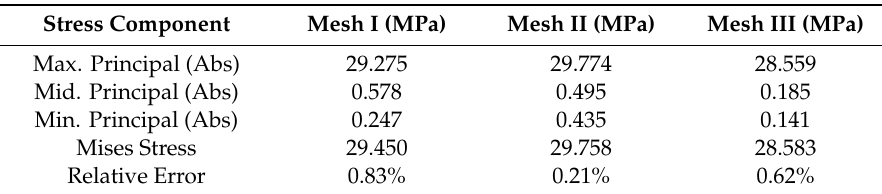
Table 8. Stress statistics and relative error for di ff erent meshes on KP3.